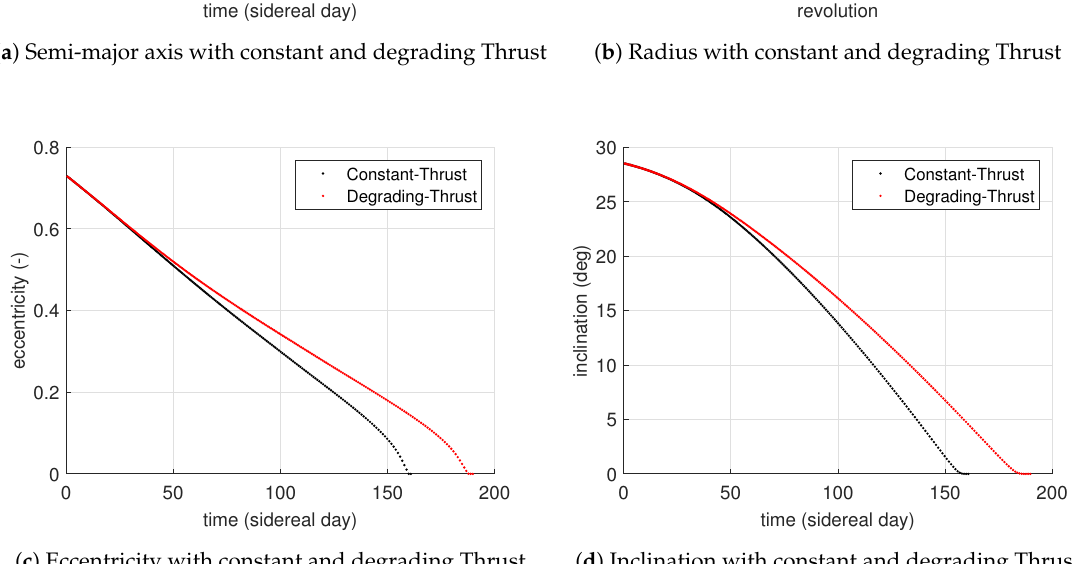
Figure 16. Osculating orbital elements of GTO-GEO trajectory with coasting ON.